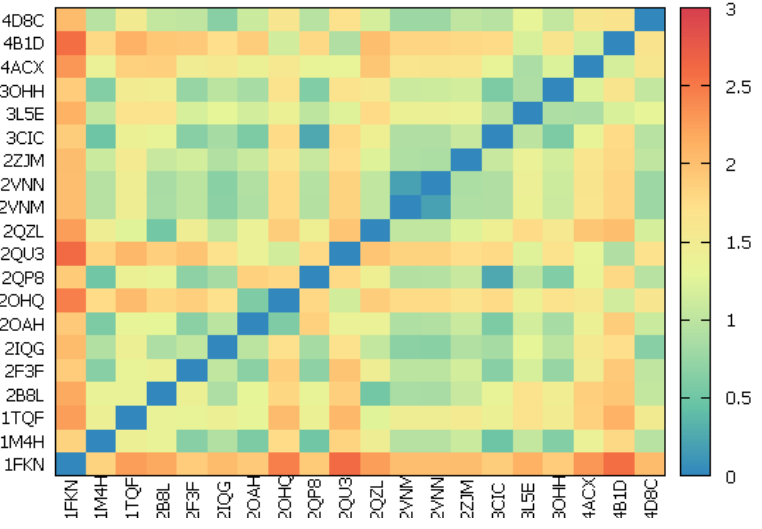
Figure 2. Matrix plot for root-mean-square deviation (RMSD) analysis. RMSD values are calculated for all heavy atoms of catalytic dyad, flap, 10s loop and residues within 8 Å from